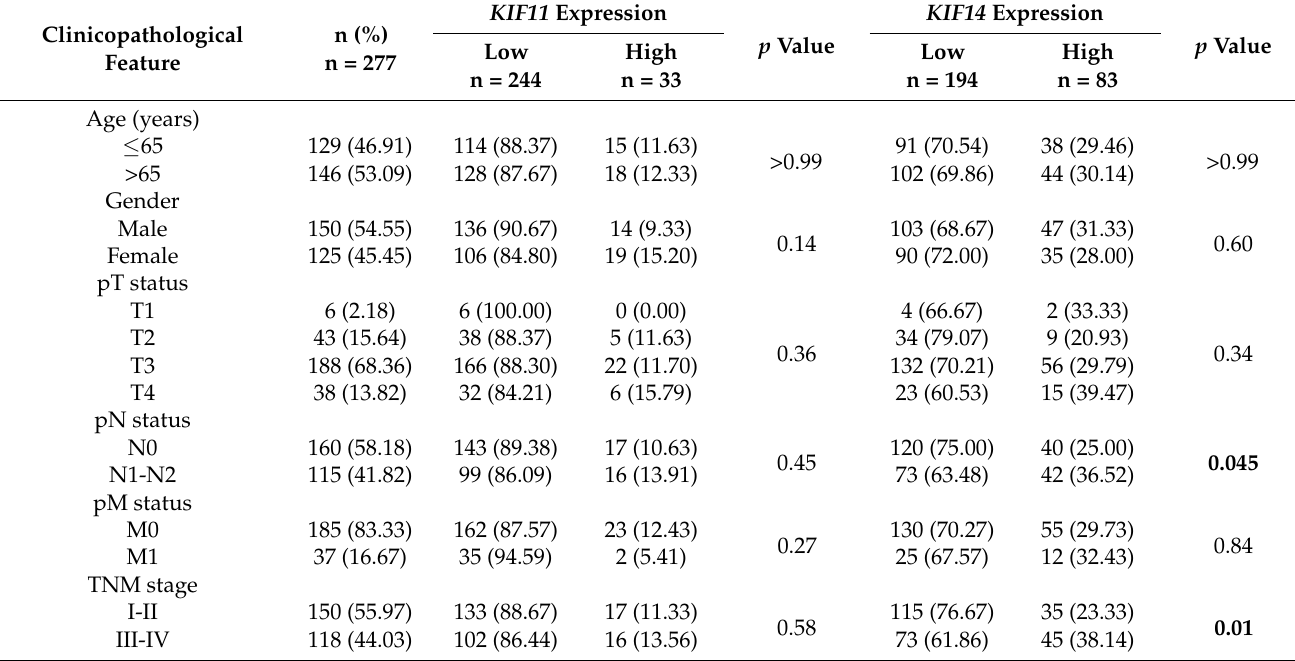
Table 3. Association of KIF11 and KIF14 transcript expression in colorectal cancer with patient characteristics. Clinicopathological